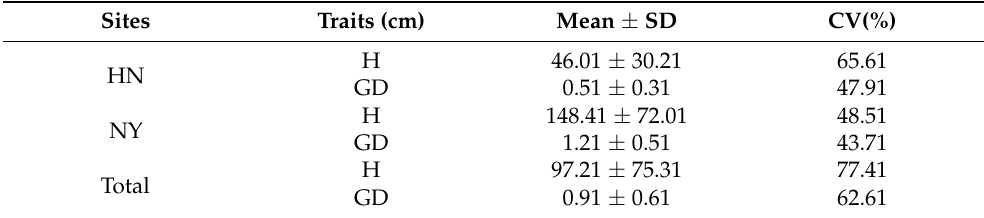
Table 4. Descriptive statistics of for height (H) and ground diameter